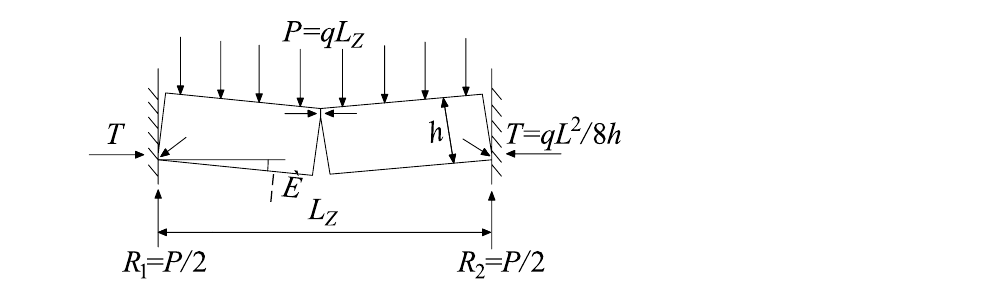
Figure 13. Mechanical model of articulated rock